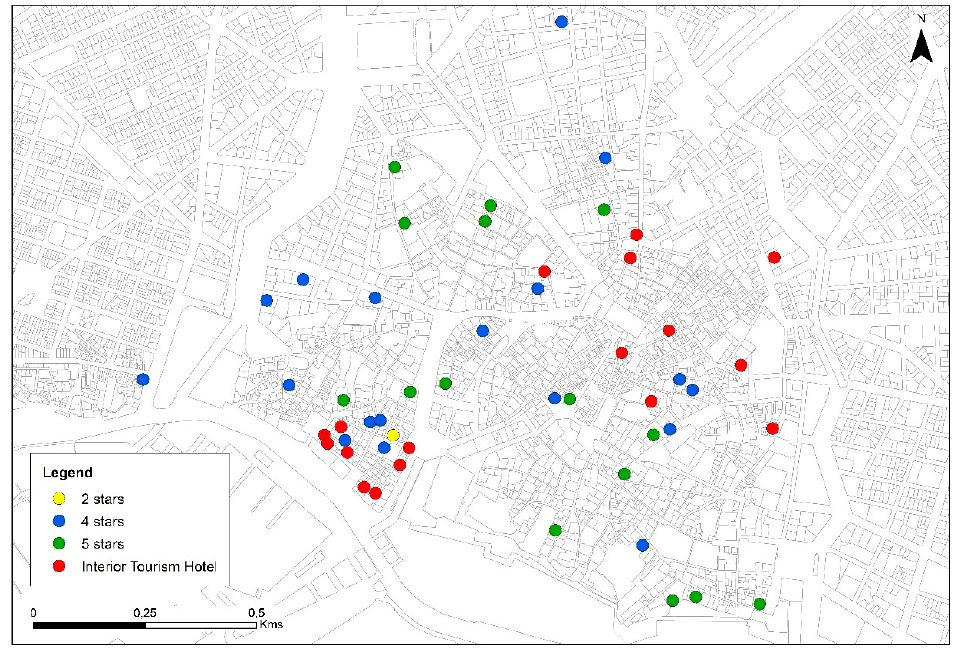
Figure 4. Geographical distribution of rooftops according to hotel category. Source: Authors.